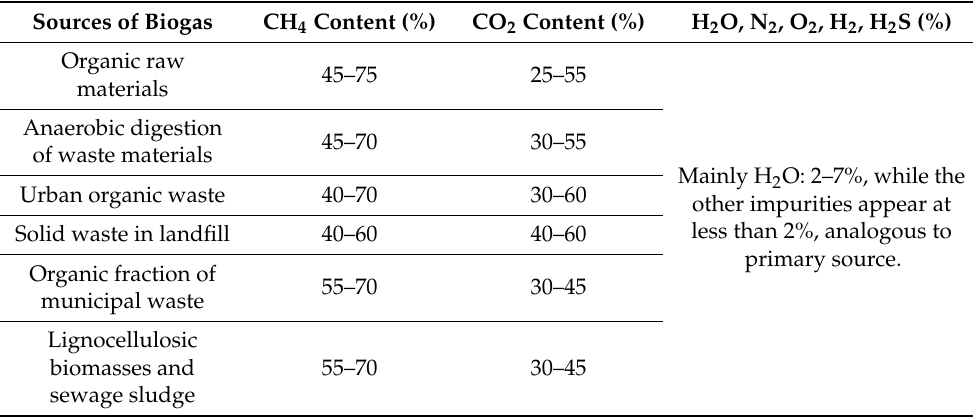
Table 1. Common substrates for biogas